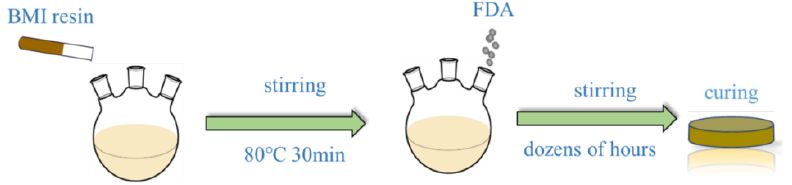
Figure 3. Reaction procedure for modified BMI resin.